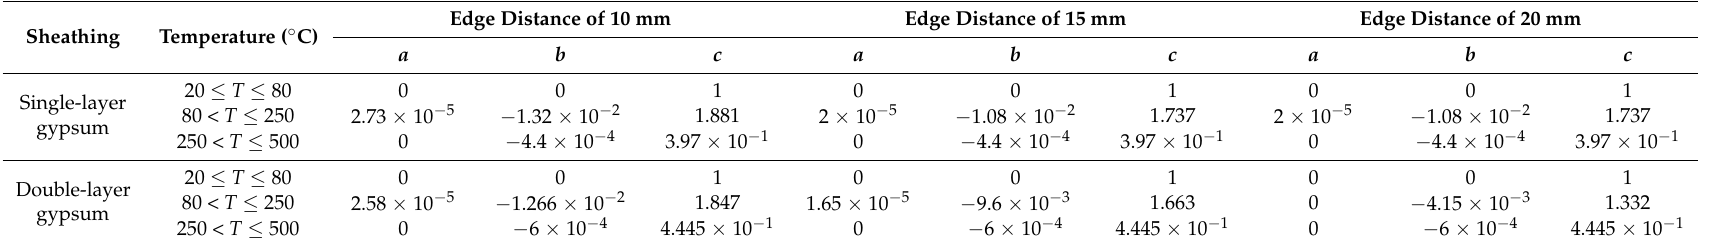
Table 3. Values of Coefficients in Equation